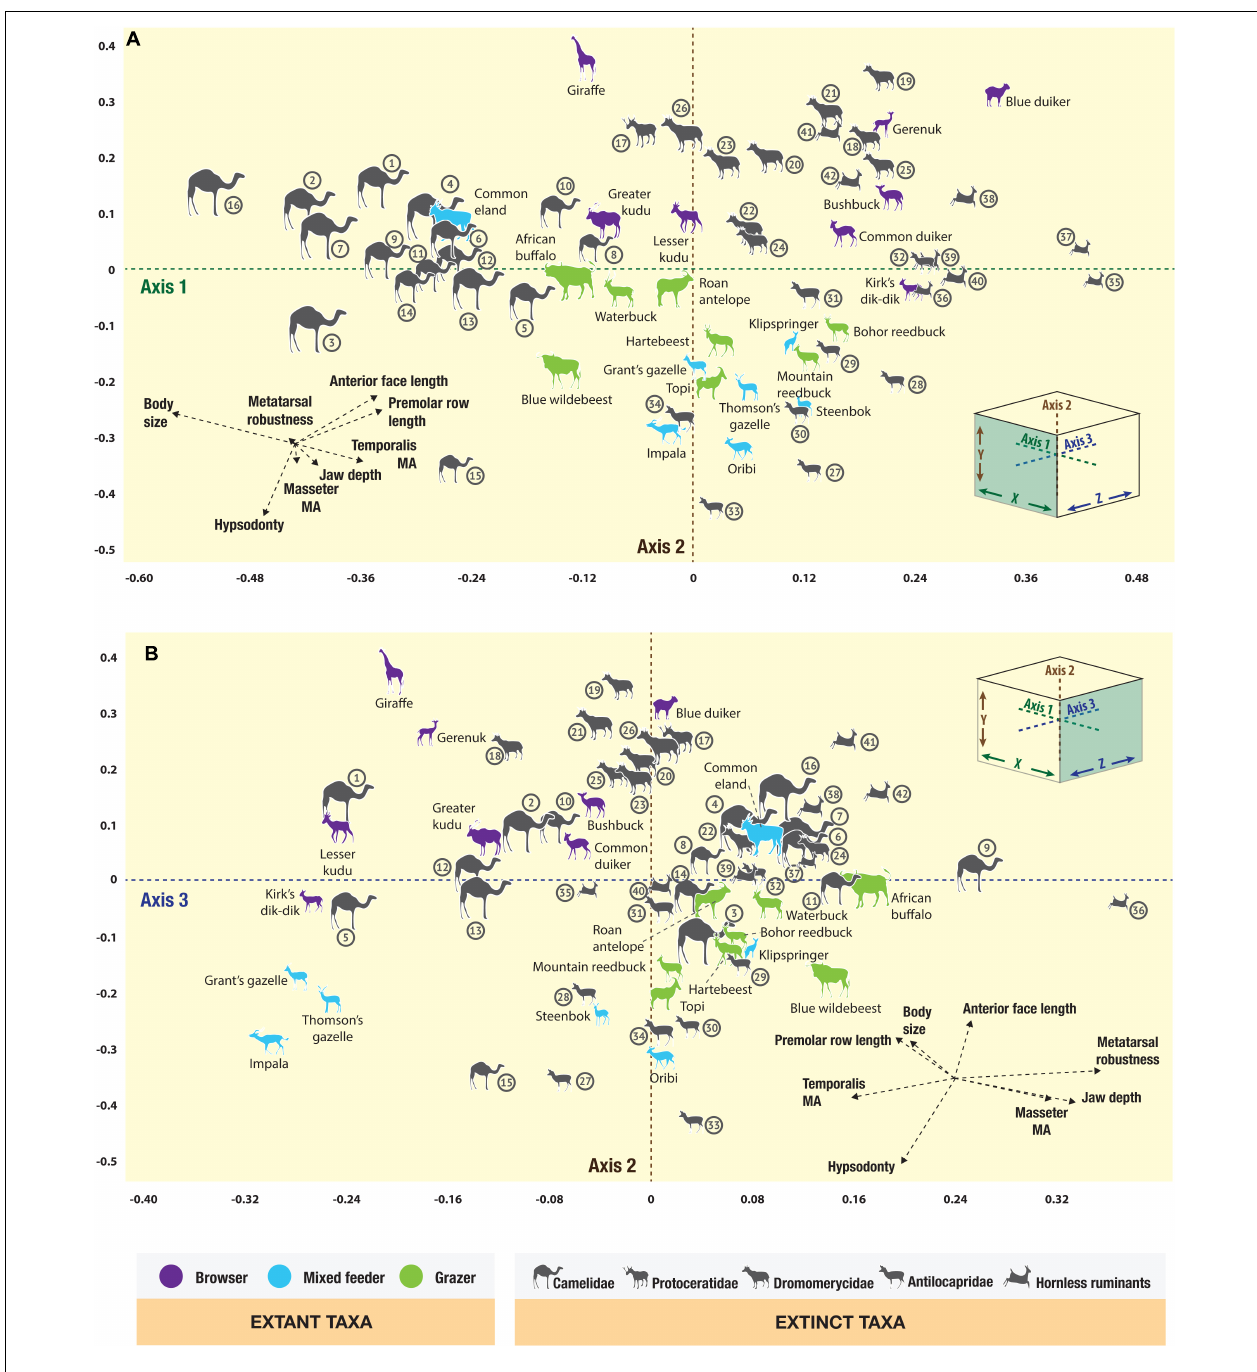
FIGURE 4 | Correspondence analysis plot of the artiodactyls from the Serengeti and from the Neogene of the Great Plains in North America, showing (A) axes one and two, (B) axes two and three. Camelidae: 1. Aepycamelus sp., 2. Alforjas magnifontis , 3. Camelops sp., 4. Gigantocamelus spatula , 5. Hemiauchenia sp., 6. Homocamelus sp., 7. Megatylopus sp., 8. Michenia sp., 9. Miolabis sp., 10. Oxydactylus sp., 11. Paramiolabis tenuis , 12. Pleiolama magnifontis , 13. Procamelus grandis , 14. Protolabis heterodontus , 15. Stenomylus sp., 16. Titanotylopus nebraskensis ; Protoceratidae: 17. Lambdoceras sp.; Dromomerycidae: 18. Barbouromeryx sp., 19. Bouromeryx sp., 20. Cranioceras unicornis , 21. Dromomeryx sp., 22. Pediomeryx hemphilliensis , 23. Rakomeryx sp., 24. Sinclairomeryx riparius , 25. Subdromomeryx scotti , 26. Yumaceras figginsi ; Antilocapridae: Subfamily Merycodontinae – 27. Cosoryx furcatus , 28. Merycodus sp., 29. Paracosoryx alticornis , 30. Paracosoryx wilsoni , 31. Ramoceros sp., 32. Submeryceros minor , Subfamily Antilocaprinae – 33. Capromeryx sp., 34. Texoceros guymonensis ; Hornless ruminants , families Gelocidae: 35. Pseudoceras sp., Hypertragulidae: 36. Nanotragulus sp., Leptomerycidae: 37. Pseudoparablastomeryx sp., and Moschidae: 38. Blastomeryx elegans , 39. Blastomeryx gemmifer , 40. Longirostromeryx wellsi , 41. Parablastomeryx advena , 42. Problastomeryx sp.